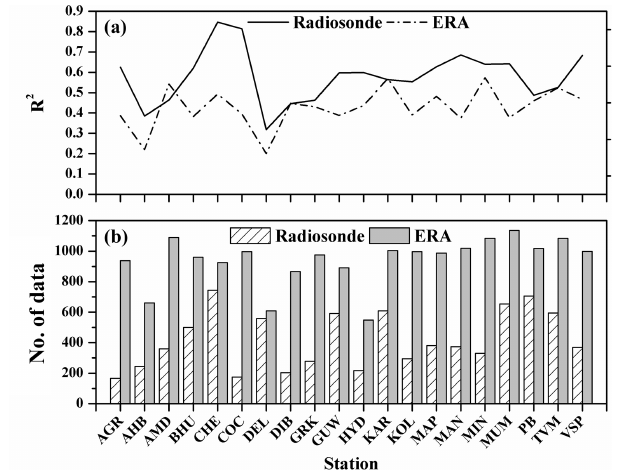
Figure 2. (a) Correlation coefficient in the comparison of INSAT- 3D CAPE with radiosonde and ERA-Interim CAPE for 20 stations in India for the period April 2014 to March 2017. (b) Number of data points in the comparison of INSAT-3D CAPE with radiosonde and ERA-Interim